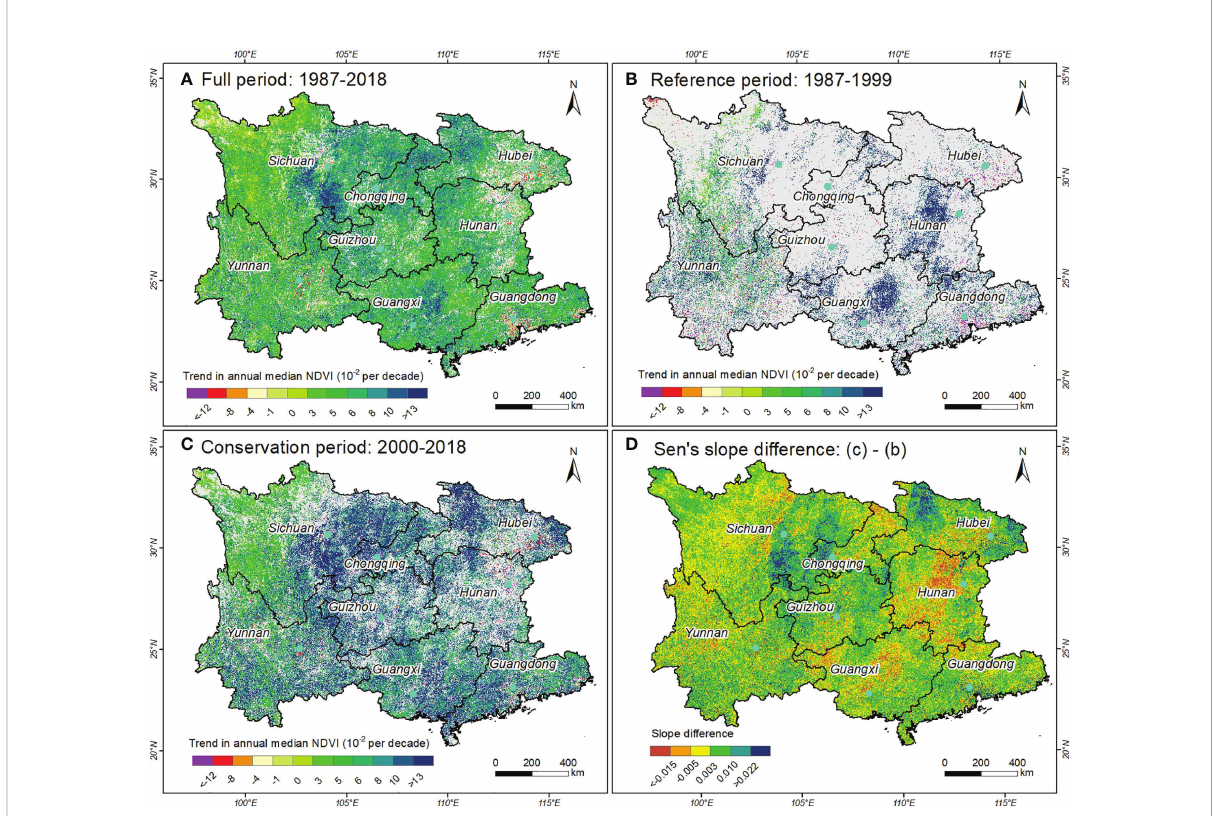
FIGURE 3 Spatial distribution patterns of NDVI trends for different periods in southern China. (A) Full time series (1987-2018), (B) reference period (1987- 1999), (C) conservation period (2000-2018), and (D) difference in Sen ’ s slope of vegetation trends calculated by Theil-Sen slope estimator between the conservation period and reference period. Note that the grey area denotes not statistically signi fi cant ( P > 0.05), and the bright green solid dot denotes the location of the capital cities of eight provinces in southern China.